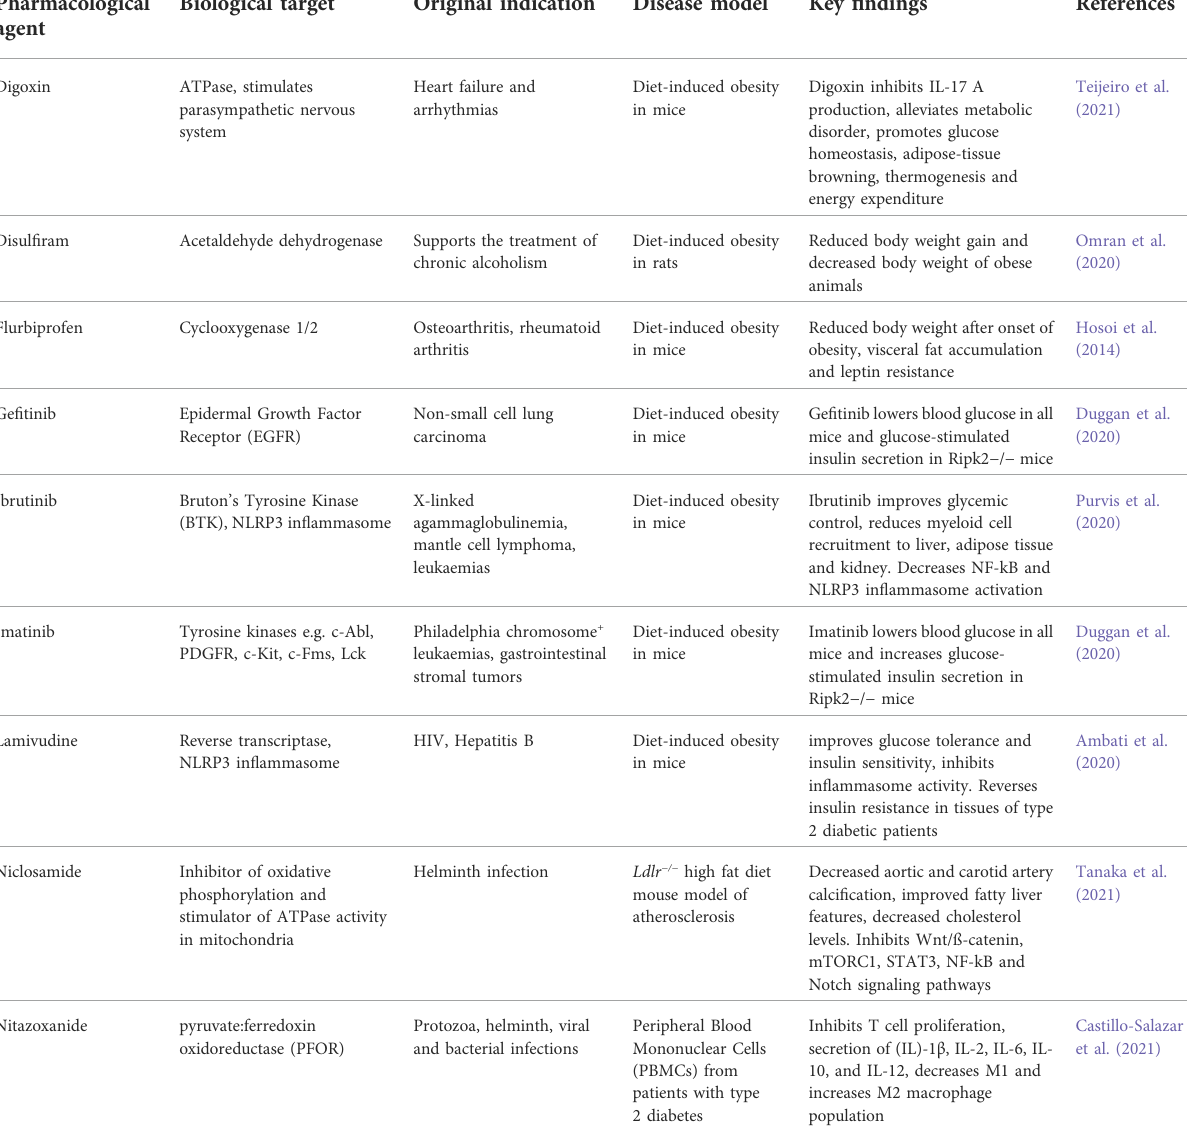
TABLE 2 Drug repurposing candidates with an anti-in fl ammatory mode of action in cardiovascular disease